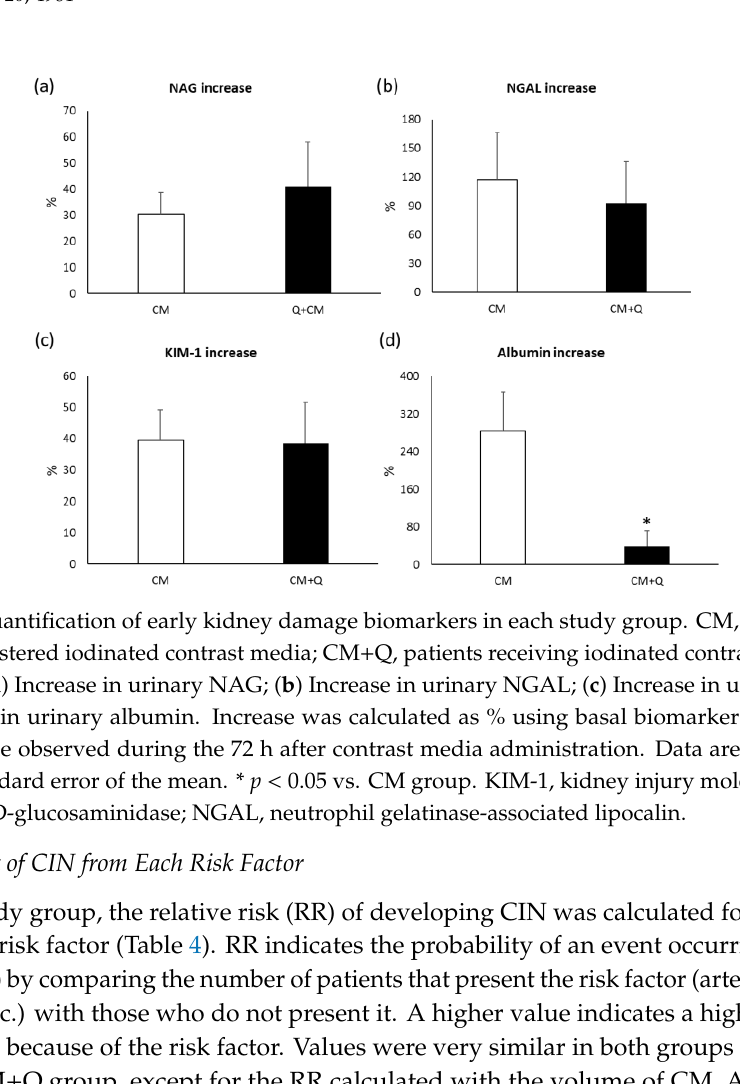
Table 4. Calculation of the relative risk to develop contrast-induced nephropathy for each risk factor. RR, relative risk; CM, patients who were administered iodinated contrast media; CM + Q, patients pretreated with quercetin before CM administration. * Statistically significant ( p < 0.05). CM Risk Factor